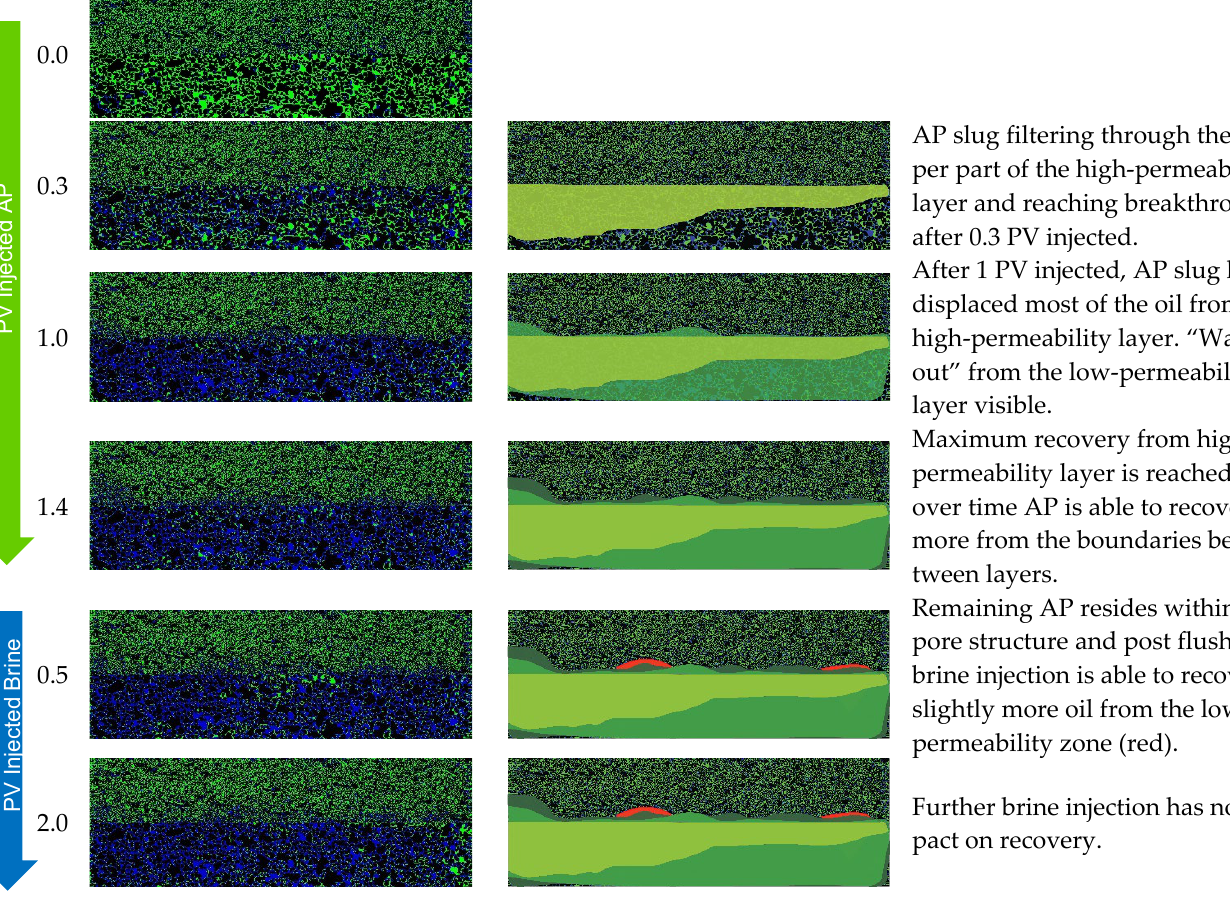
Figure 10. Displacement fronts during each slug injection in Exp. 1 (left: segmented images after analysis; right: post-edit images highlighting displaced area).